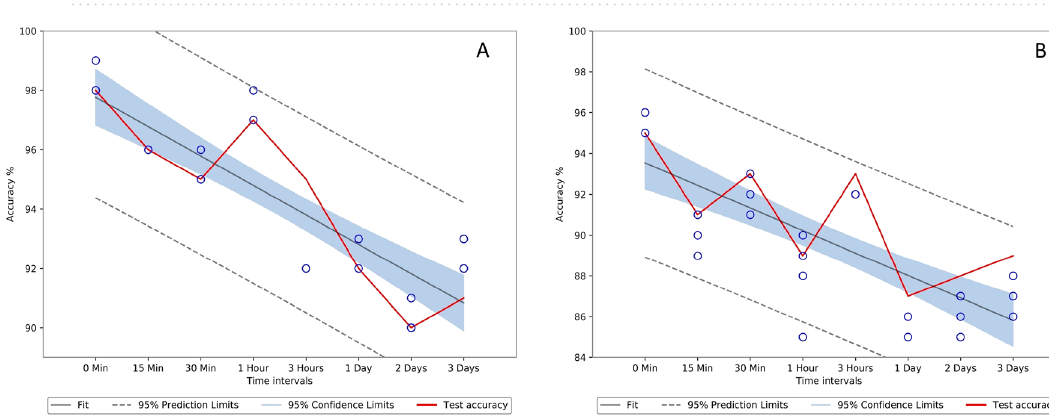
Figure 13. Paper4 confidence interval (CI) plot for beverage classification, ( A ) represents CI for SVM only and ( B ) represents CI for SVM with encoder.